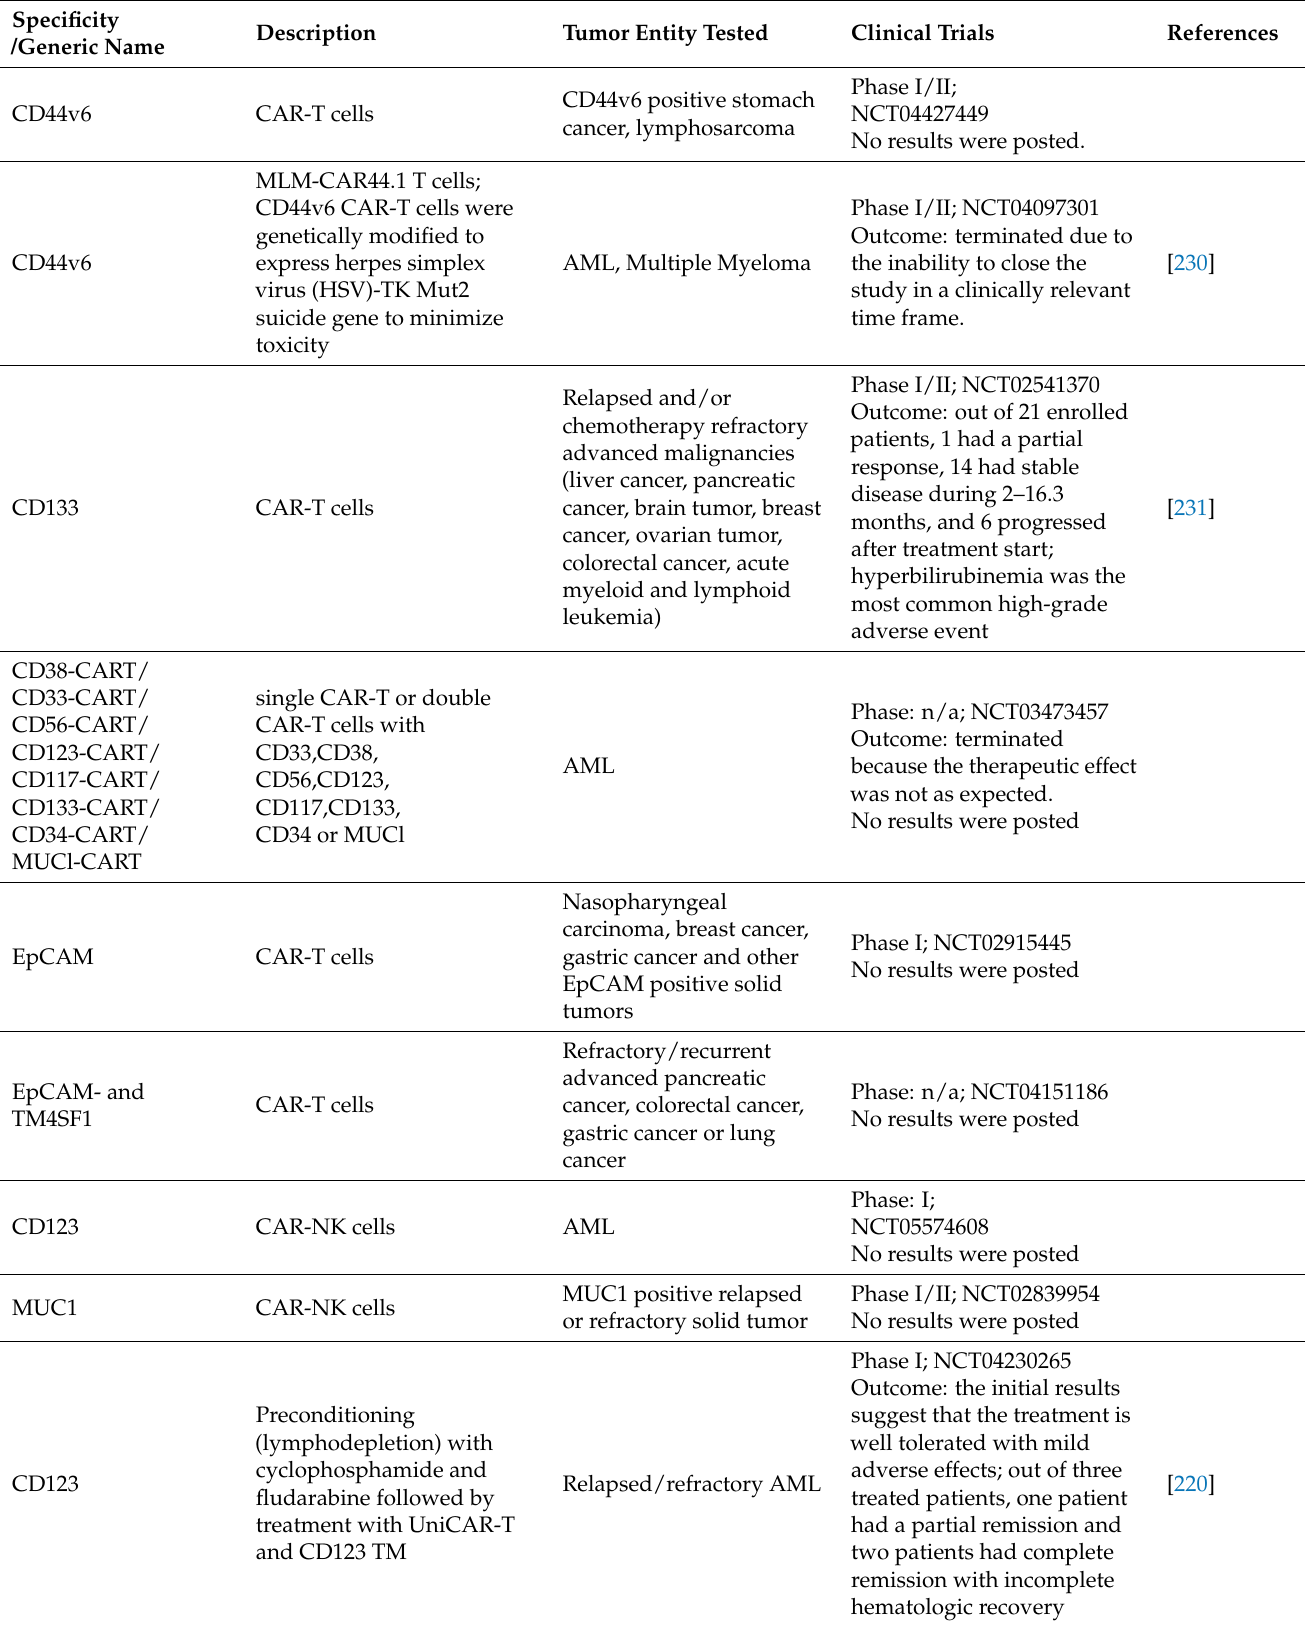
Table 2. Selected clinical trials for immune cell-based therapies targeting CSC-related tumor